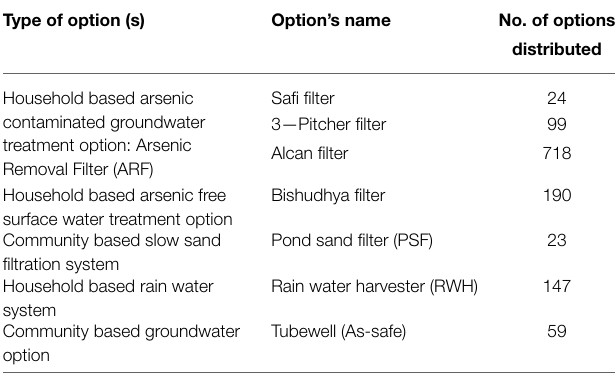
TABLE 1 | Safe drinking water options provided among the